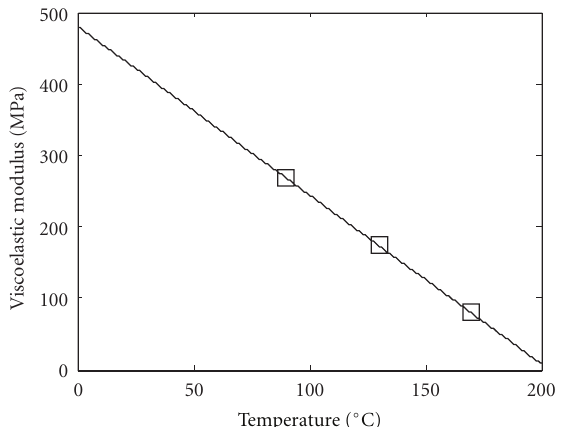
Figure 4: Relations between viscoelastic modulus E 1 and tempera- ture.